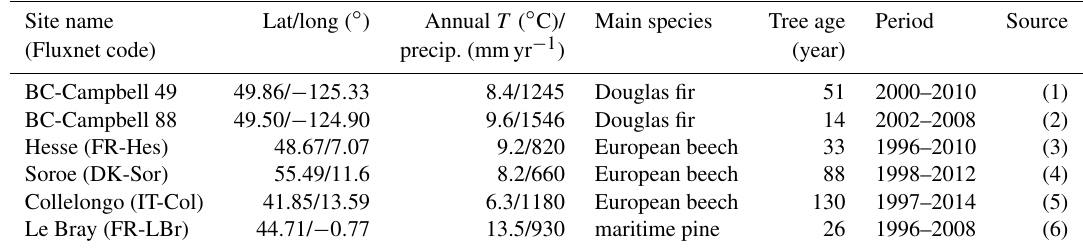
Table 4. Characteristics of the sites selected for long-term series of daily fluxes of net radiation, latent heat and CO 2 .